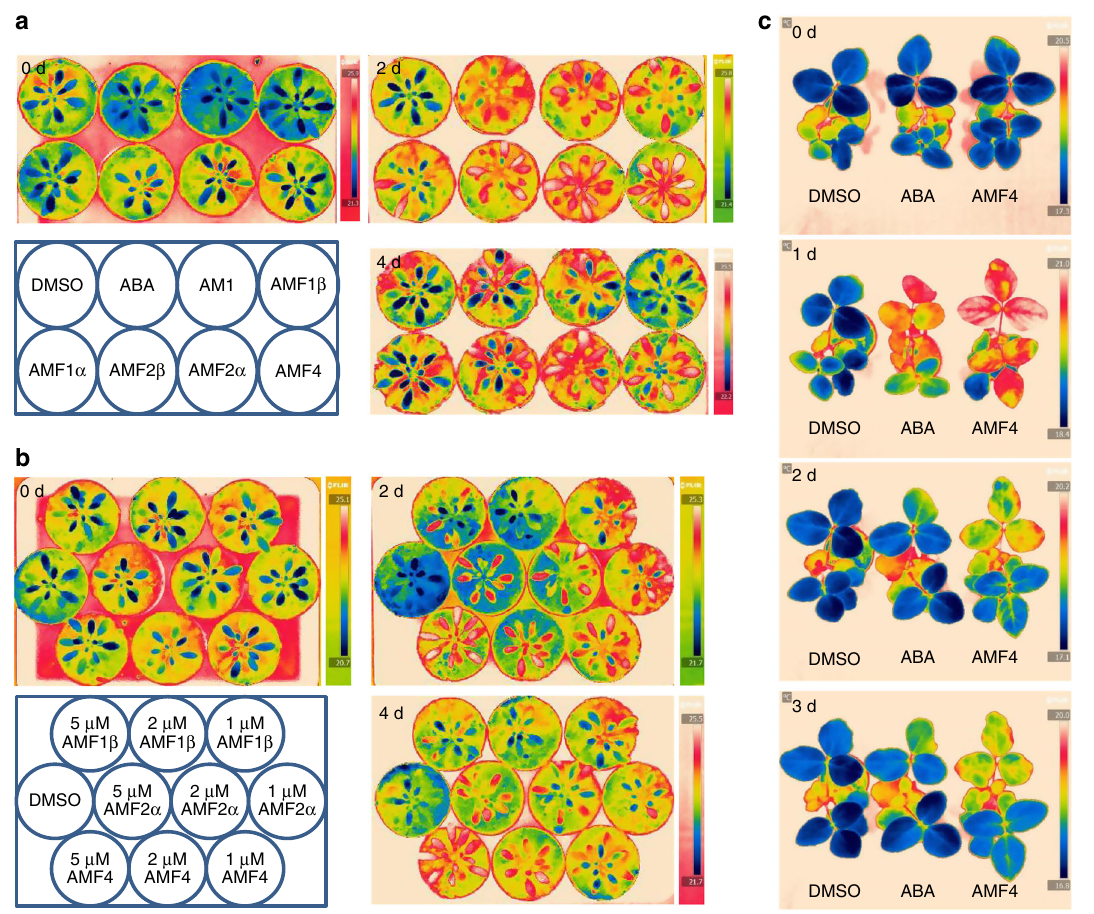
Fig. 5 AMF sprays increase leaf temperature. a Leaf surface temperature is increased by treatment with AMFs. Four-week-old Arabidopsis aba2-1 mutants are sprayed with 5 μ M indicated chemical solutions, and DMSO is used as the control. Plants are photographed with an IR camera before treatment (0 days) and at 2 or 4 days after treatment. b AMF sprays increase leaf temperature in a dose-dependent manner. Four-week-old Arabidopsis aba2-1 mutants are treated with corresponding chemicals at 5, 2, or 1 μ M, and DMSO is used as the control. Plants are photographed with an IR camera before treatment (0 days) and at 2 or 4 days after treatment. c AMF4 increases soybean leaf temperature. Soybean plants are treated with 20 μ M (+)-ABA or AMF4, and DMSO is used as the control. Plants are photographed with an IR camera before treatment (0 days) and at 1, 2, or 3 days after